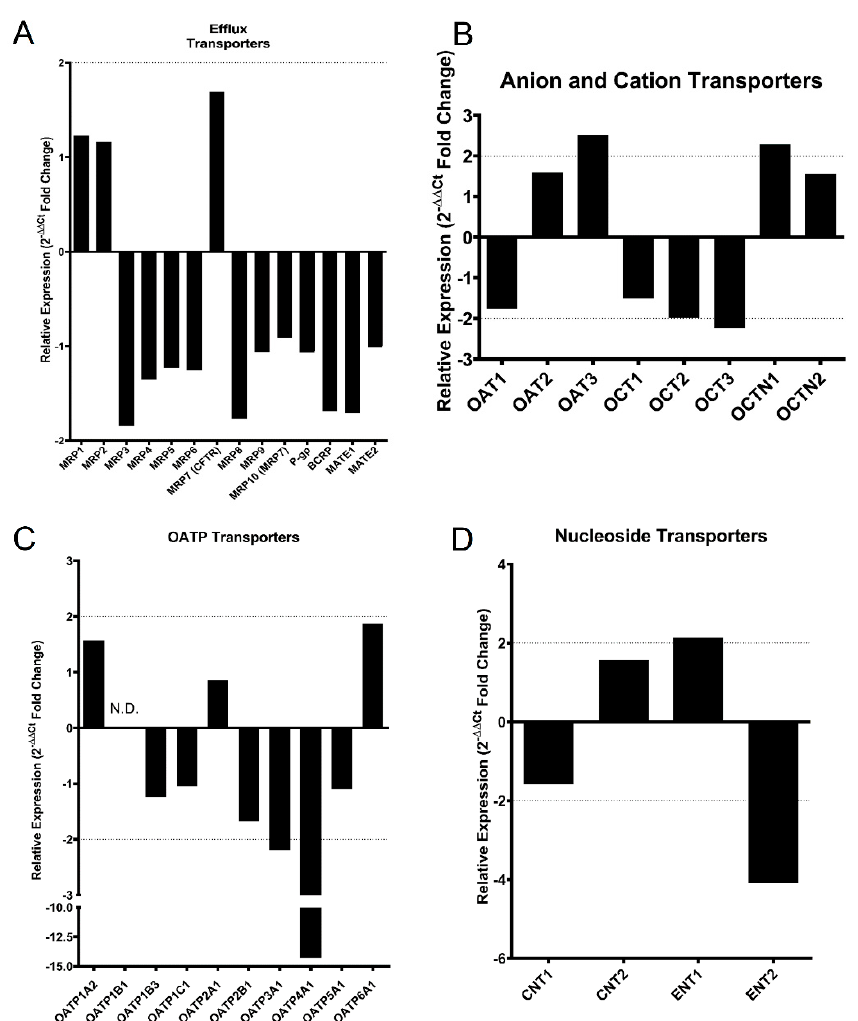
Figure 4. ( A ) Relative mRNA expression of various human xenobiotic efflux transporter genes assessed by RT-qPCR. ( B ) Relative mRNA expression of human anion and cation transporter genes in the SLC22A family. ( C ) Relative mRNA expression of human organic anion transporting polypeptide transporter genes in the SLC21 family. OATP1B1 expression was not detected in either cell type and denoted as N.D. ( D ) Relative mRNA expression of human concentrative and equilibrative nucleoside transporters. All fold-change values were calculated using the 2 −ΔΔ Ct method. Ct values were normalized to GAPDH as the reference gene.